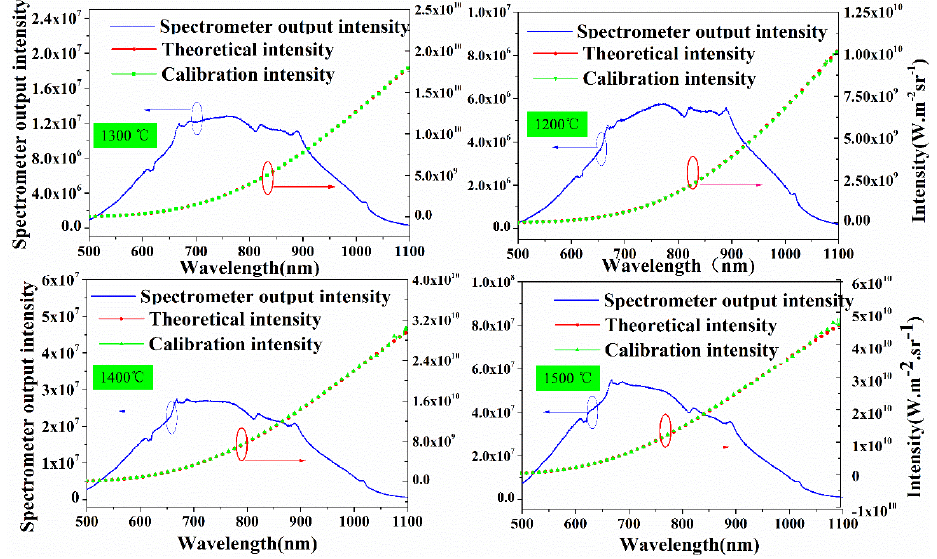
Figure 6. Spectra before and after calculation at 1200 °C, 1300 °C, 1400 °C, and 1500 °C.